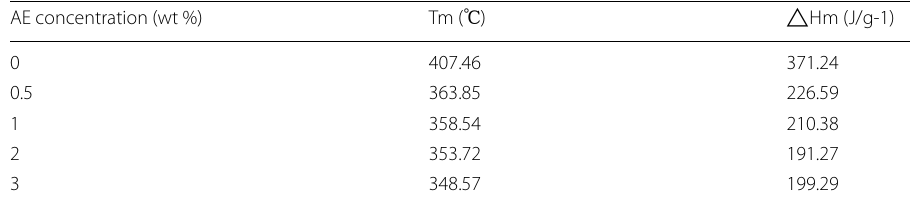
Table 3 DSC data of PU/AE nanofibers for different AE concentrations AE concentration (wt %)